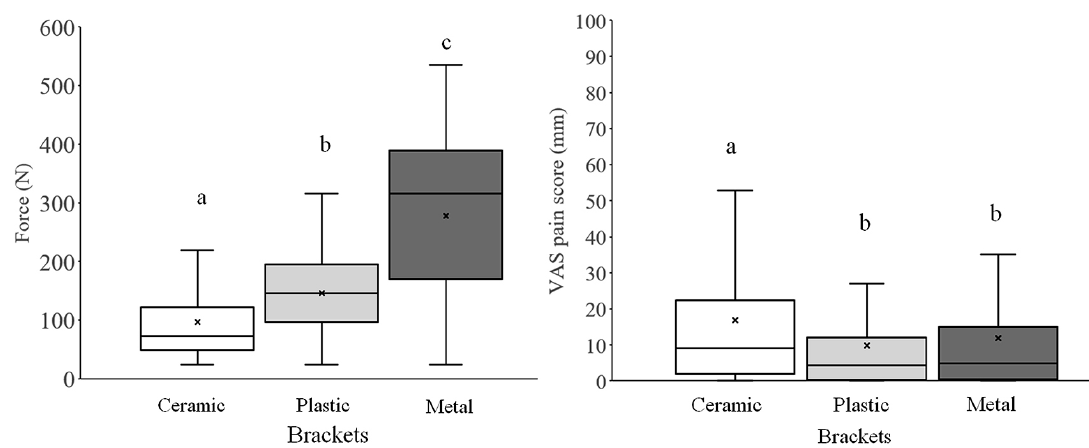
Figure 5- Box-and-whisker plots of removal forces and pain for each bracket. The elements of the box plot are identical to the elements in Figure 4. Different letters between bracket groups indicate a significant difference (p<0.05). The debonding force was significantly higher for the metal bracket than for other